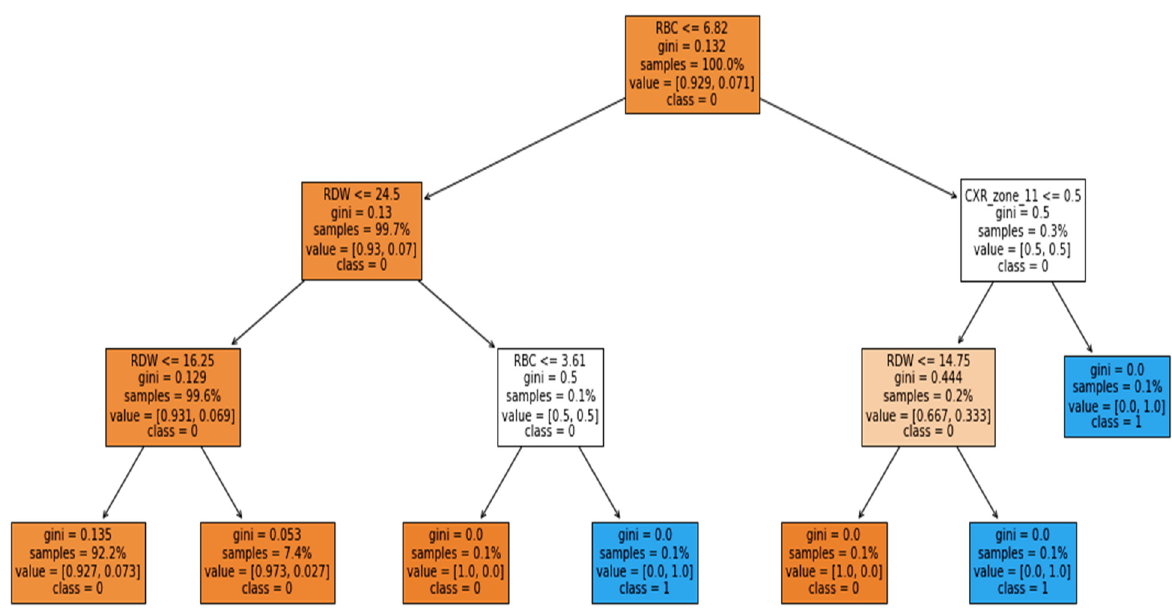
Figure 13. Case 3: Ventilator with binary classification.